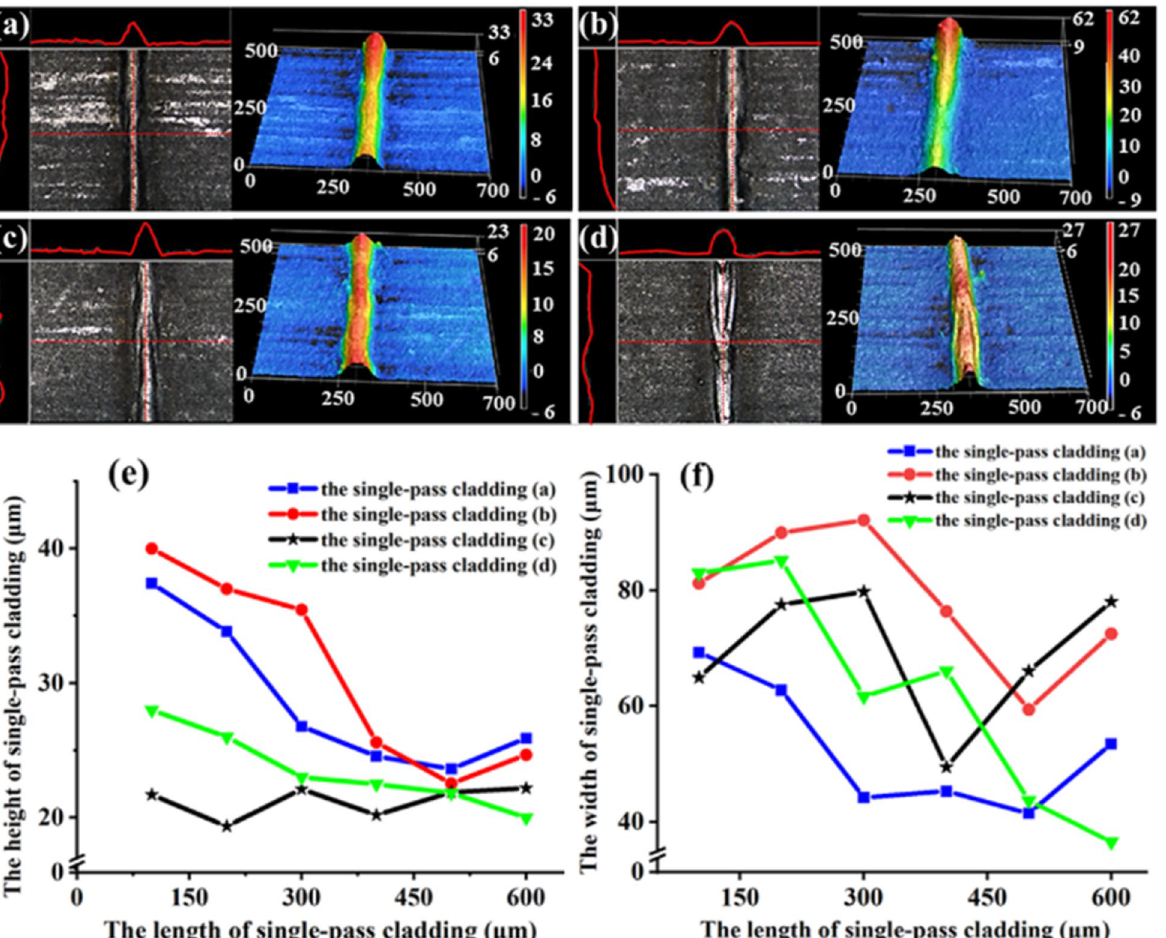
Figure 5 a – d Different single-pass claddings; e The height variation of single-pass claddings; f The width variation of single-pass